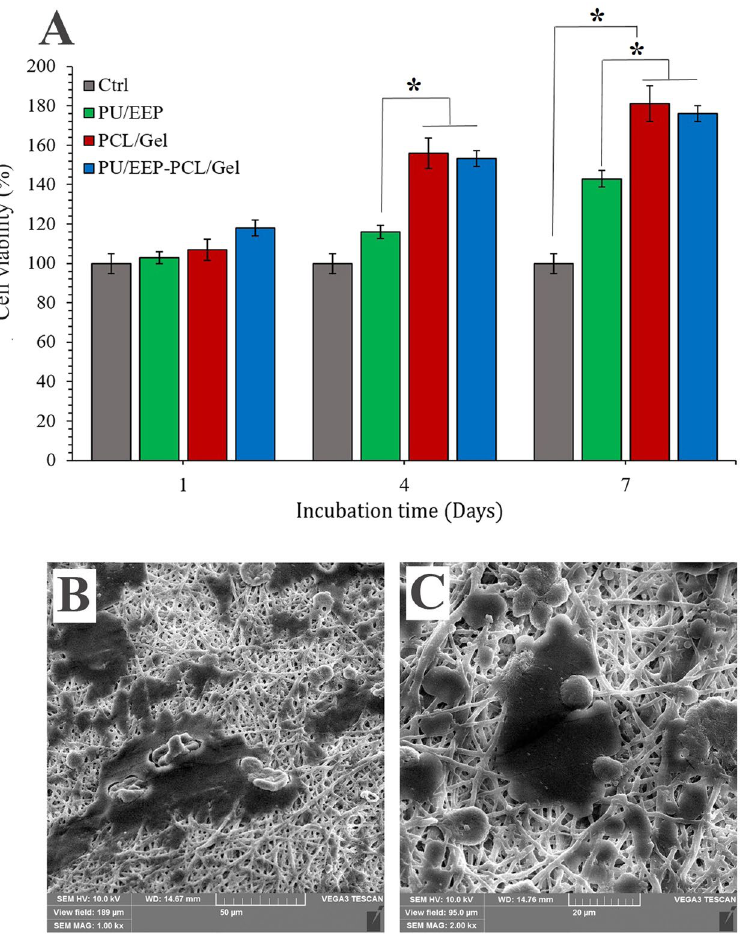
Figure 8. ( A ) Investigation of the PCL/Gel scaffolds’ biocompatibility with the L929 fibroblasts according to cell viability assay after 1, 4, and 7 days incubation ( * P < 0.05). ( B ) SEM images of the fibroblast cells on the surface of the PCL/Gel scaffold after 7 days from seeding the